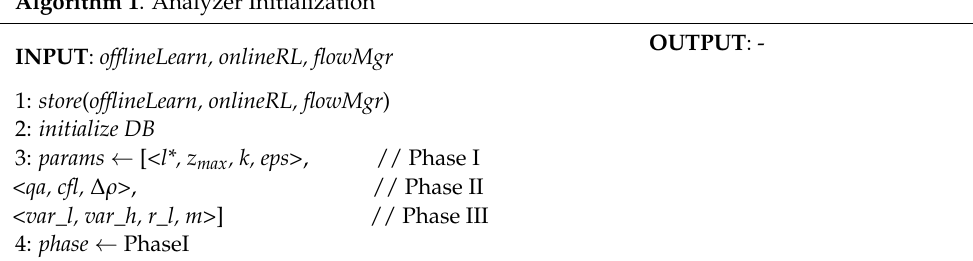
Algorithm 1 . Analyzer